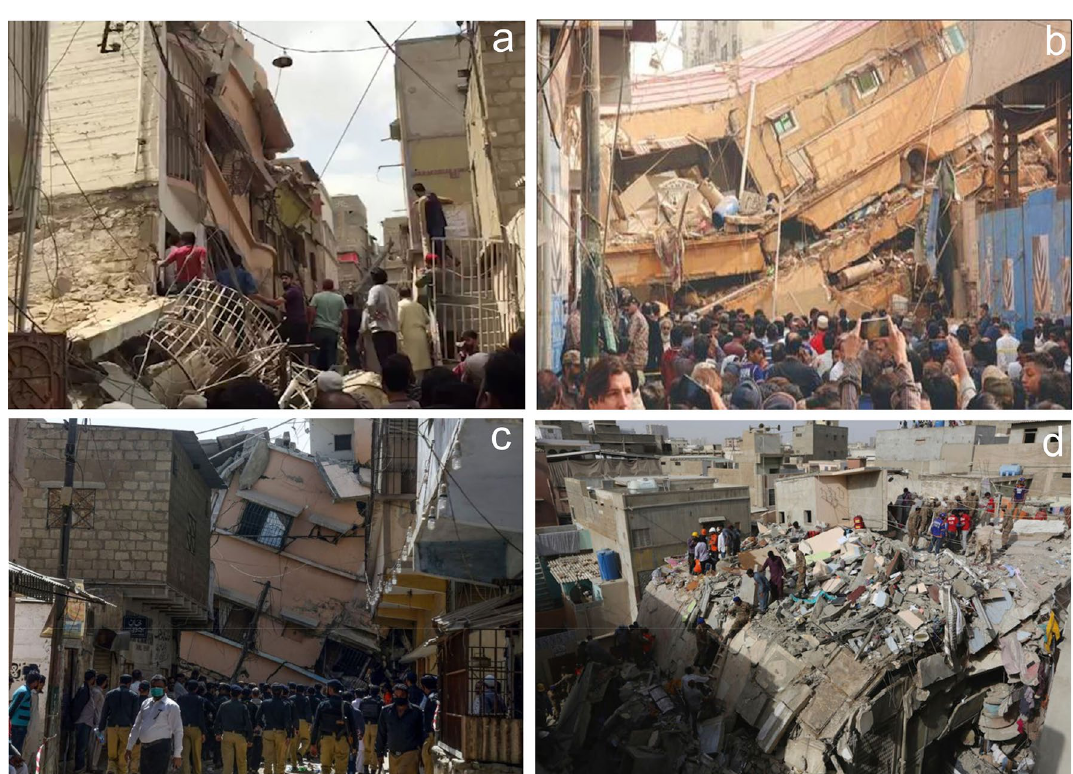
Figure 14. Land subsidence in different places of Karachi City. ( a ) Collapsed residential building at Rizvia Society, ( b ) Another collapsed at located in Soomro Street near Timber Market, Karachi City, ( c ) collapse residential building at Azizabad area, ( d ) Southern port city of